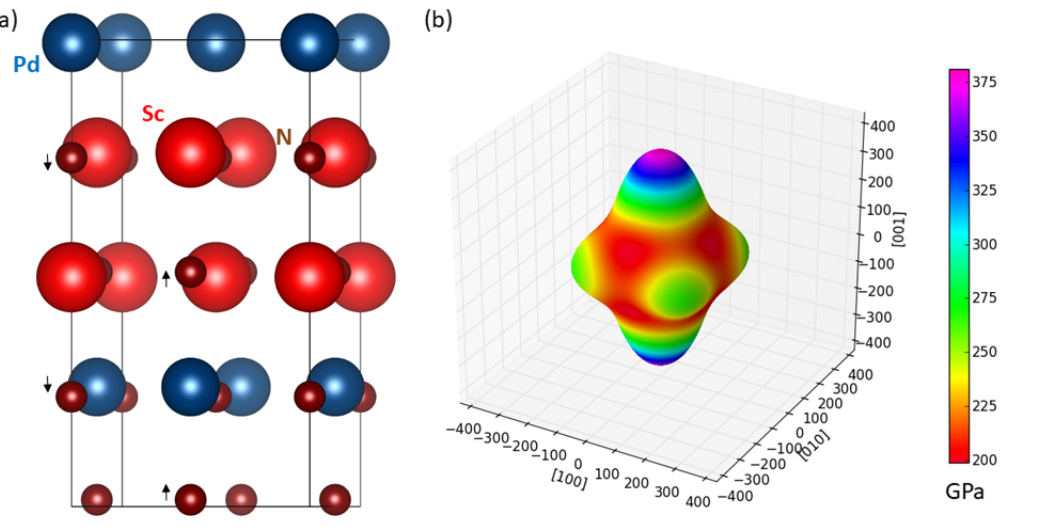
Figure 8. Schematic visualization of 16-atom ScN/PdN supercell ( a ) and the corresponding directional dependence of the Young’s modulus ( b ). The calculations for this nanocomposite were performed using 7 × 7 × 4 k-point grid. Small black arrows indicate the shifts of N atoms off the transition-metal planes perpendicular to the [001]